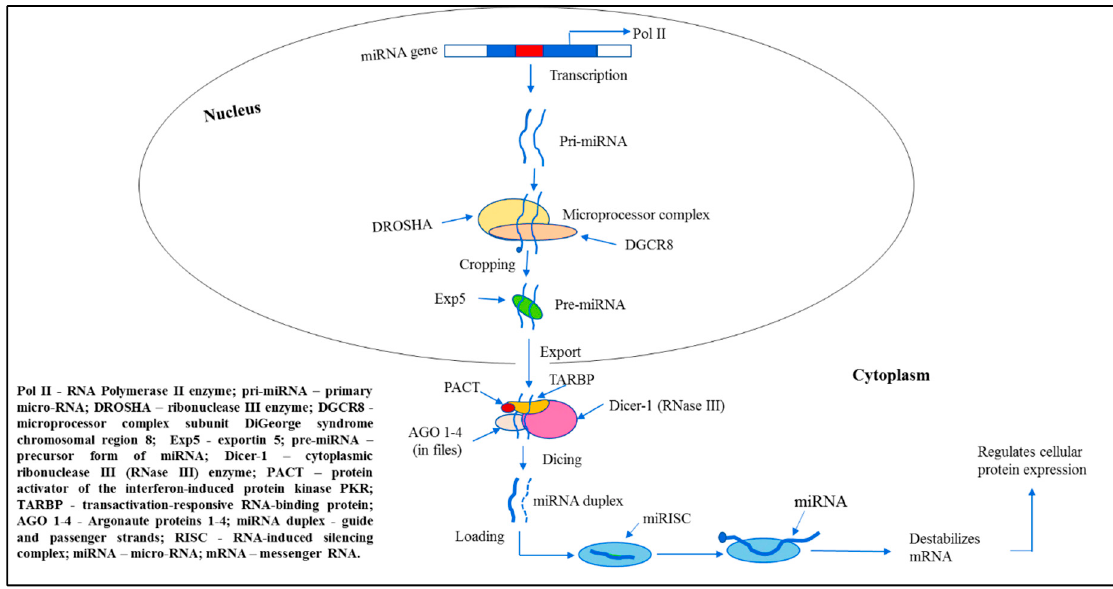
Figure 1. MiRNA biogenesis: Canonical pathway.